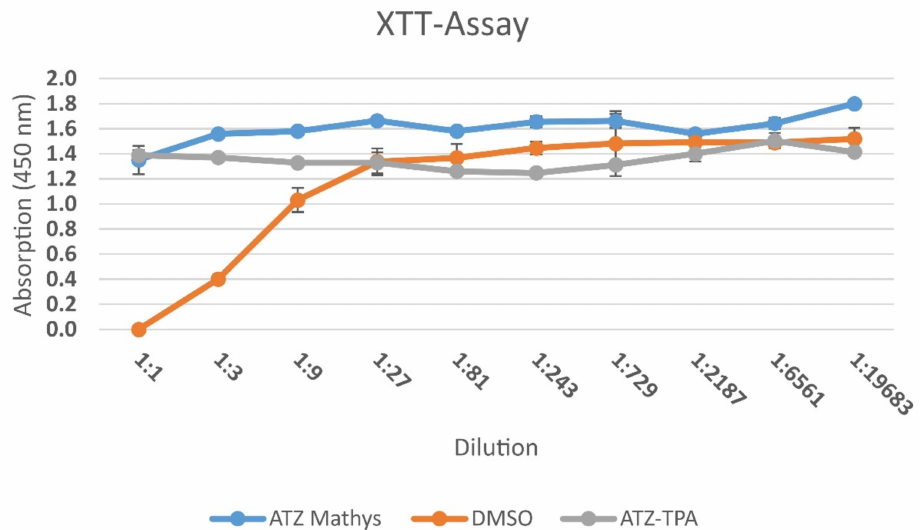
Figure 7. XTT assay of MC3T3 cells for the detection of the cytotoxicity of finished processed material (ATZ-Mathys and ATZ-TPA). Ceramic from Mathys was used as reference material and DMSO as negative control ( n = 4 technical